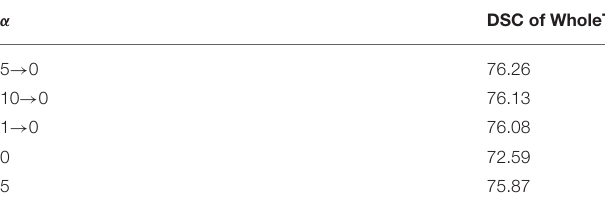
TABLE 5 | Sensitivity analysis of the hyperparameter α